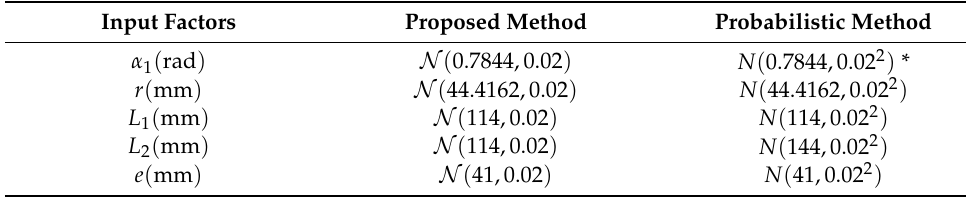
Table 1. Distribution parameters of input factors. Input